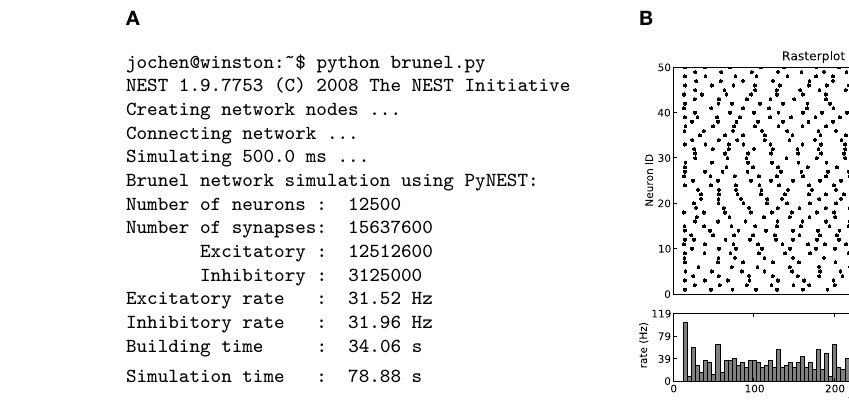
FIGURE 5 | Results of the balanced random network simulation. (A) The transcript of the simulation session shows the output during network setup and